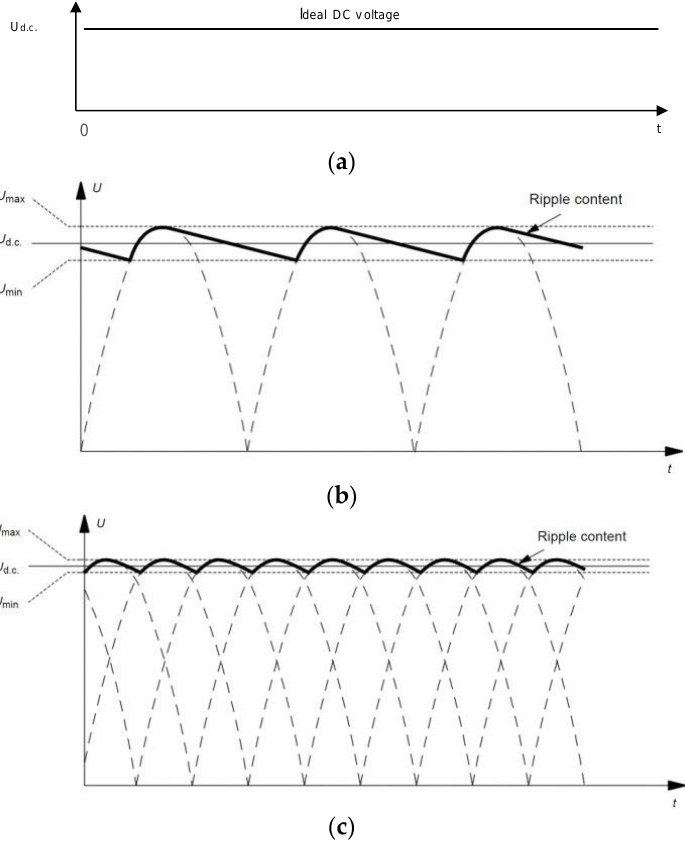
Figure 1. DC voltage shapes produced by different DC power sources: ( a ) Ideal DC voltage, ( b ) single-phase AC/DC conversion, and ( c ) three-phase AC/DC conversion.